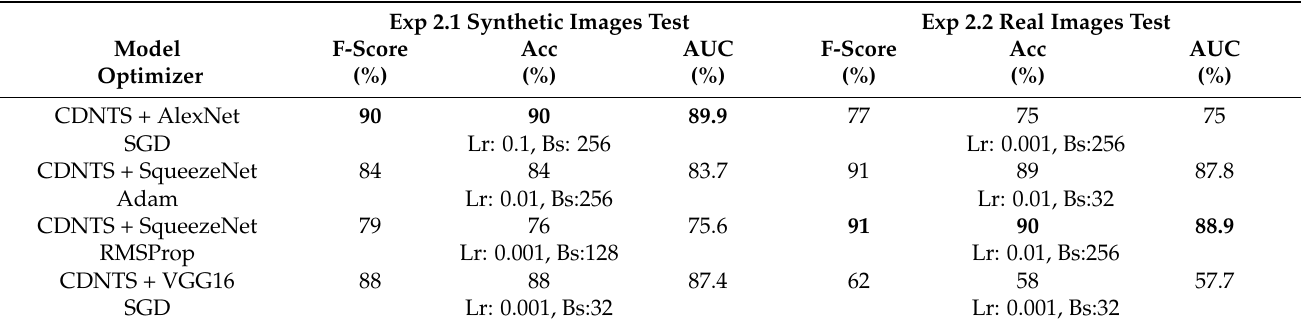
Table 3. Experiment 2: CDNTS and deep learning-based networks’ F-score, accuracy, and AUC values of test results. It shows the test success of networks trained using by CDNTS layer. Values that styled bold represent the most successful test listed. Lr: Learning Rate, Bs: Batch